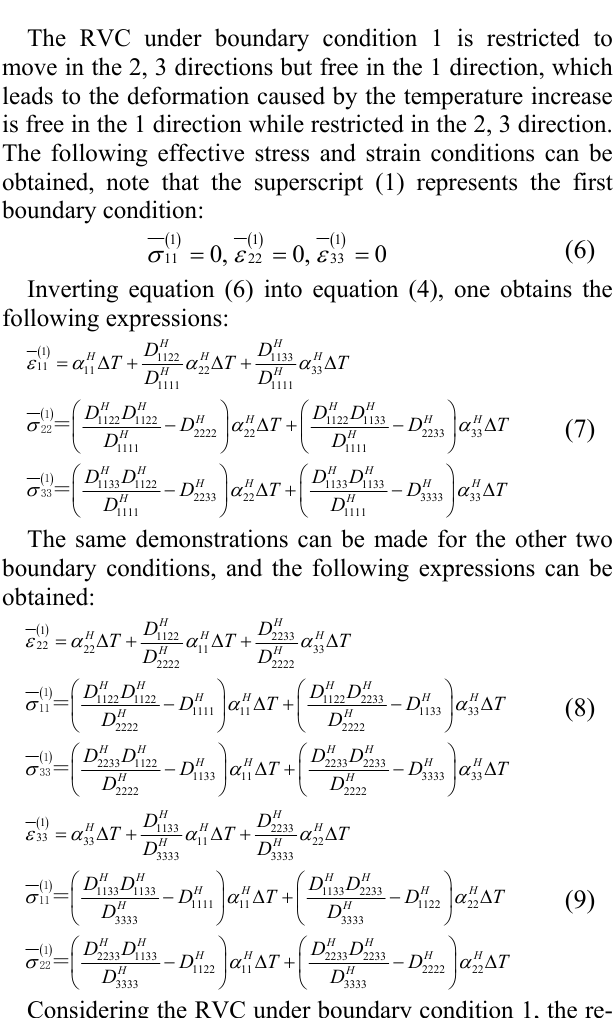
(a) 1-dirction cross-section (b) 2-dirction cross-section Fig. 4. RVC under boundary condition